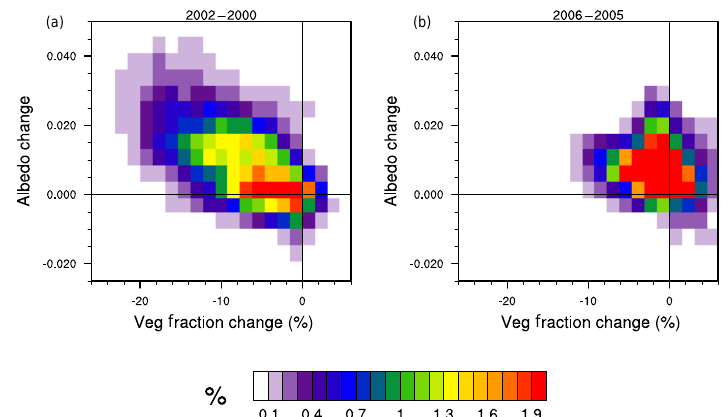
Figure 9. The bivariate joint probability distribution of the albedo and vegetation changes in the 2002 drought (2002–2000) and the 2006 drought (2006–2005). Colours show the percentage of grid cells that fall within each change in albedo and/or change in vegetation fraction